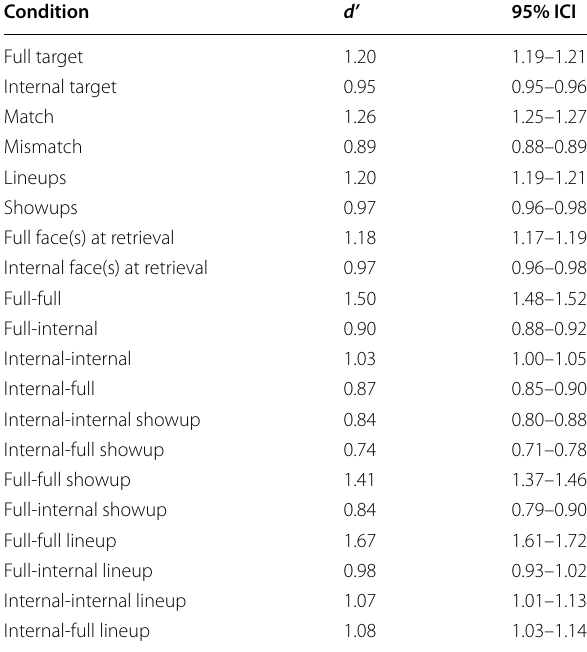
Table 6 Estimates of theoretical discriminability and inferential confidence intervals (ICI) for each